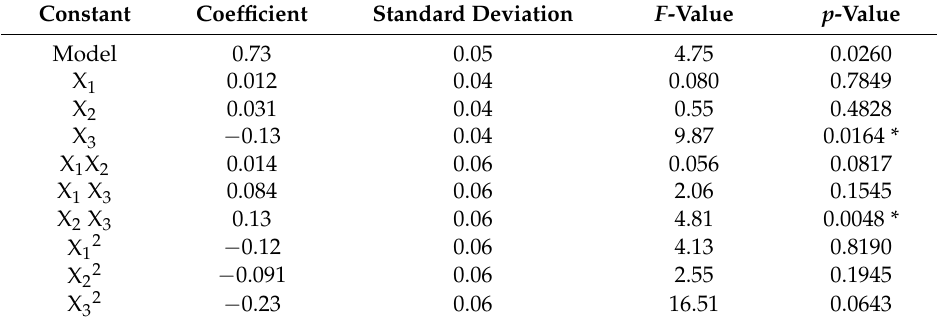
Table 2. Analysis of variance (ANOVA) of the regression